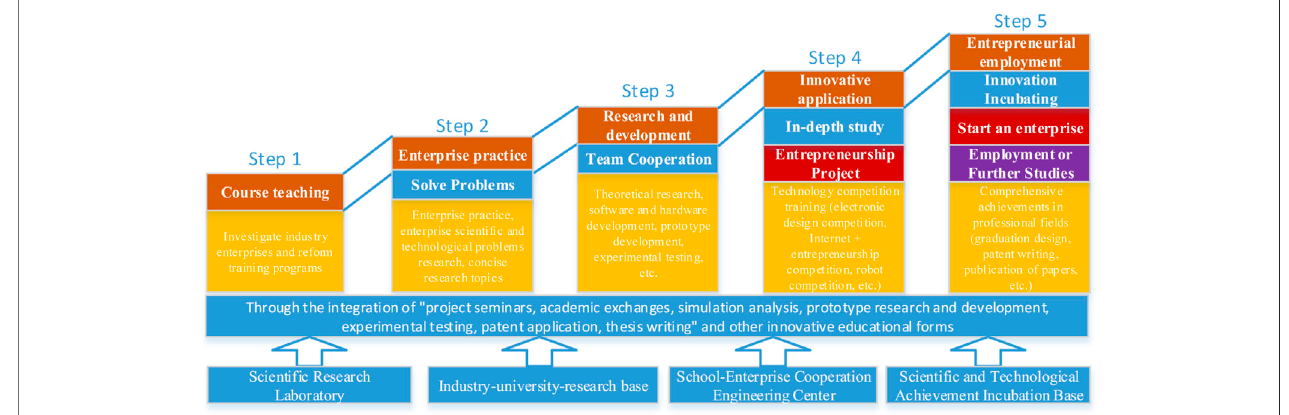
FIGURE 2 | School-enterprise collaboration fi ve-level progressive undergraduates training model.